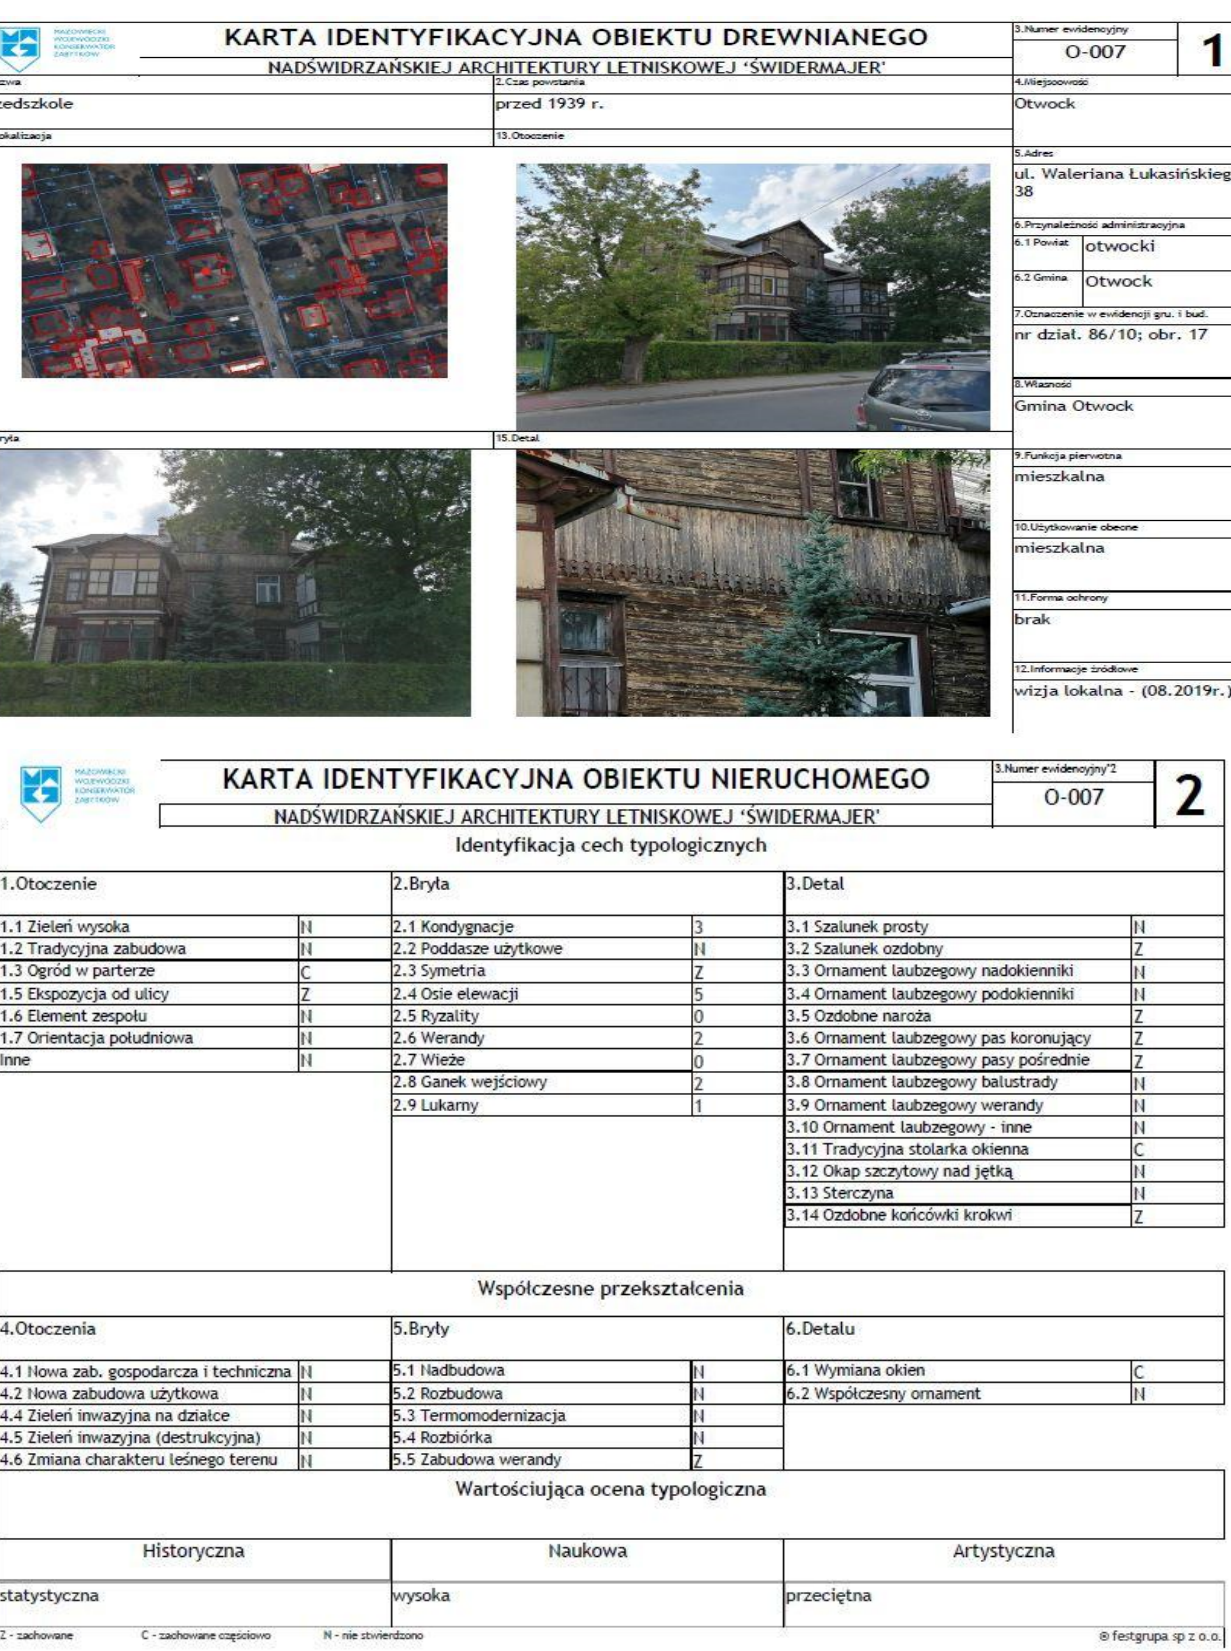
Figure 5. A sample of a completed object car: page 1 and page